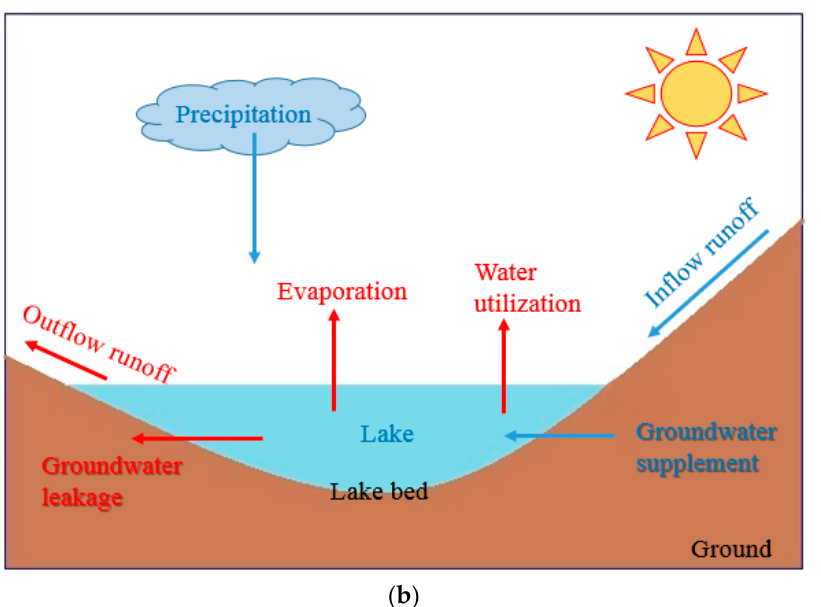
Figure 4. ( a ) Hydrological relationship diagram of the Poyang Lake. ( b ) Schematic diagram of the hydrological cycle of the lake.